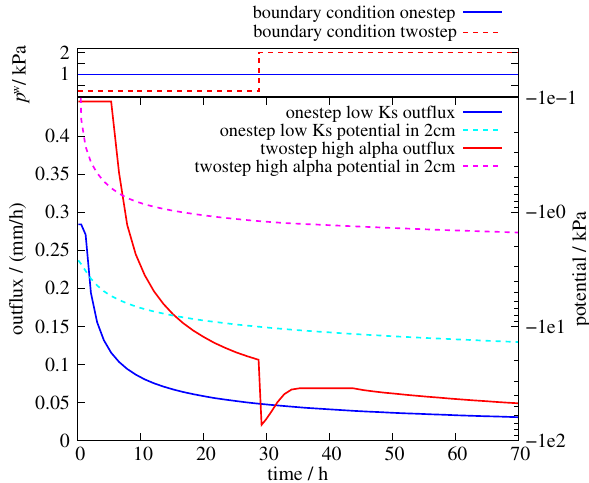
Fig. 5. Water flux at the upper boundary j w and potential in 2cm depth for the “onestep” experiment with 20 times lower K s , as well as for the twostep experiment with 20 times higher α . The former stays virtually no time in regime I due to the very low conductivity. The latter shows a more distinct switch-back to regime I but struc- turally it is identical to the original soil. Notice that p w jumps from equilibrium to 1kPa and 0.25kPa, respectively, at t =